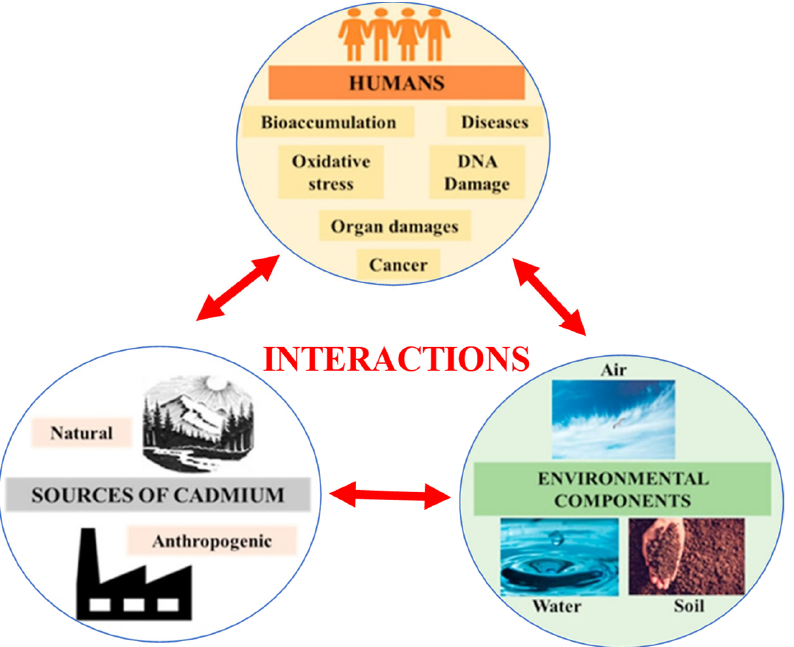
Figure 1. The effects of Cd pollution on the environment and human health, reproduced from [18], with permission from Elsevier, 2021